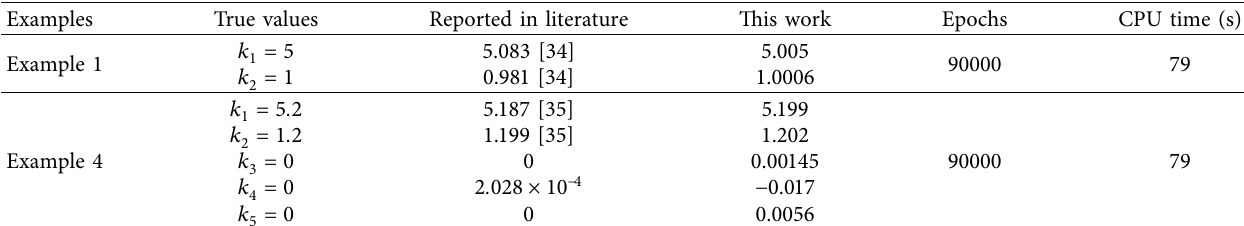
Table 8: Comparison of of results obtained vs. reported in